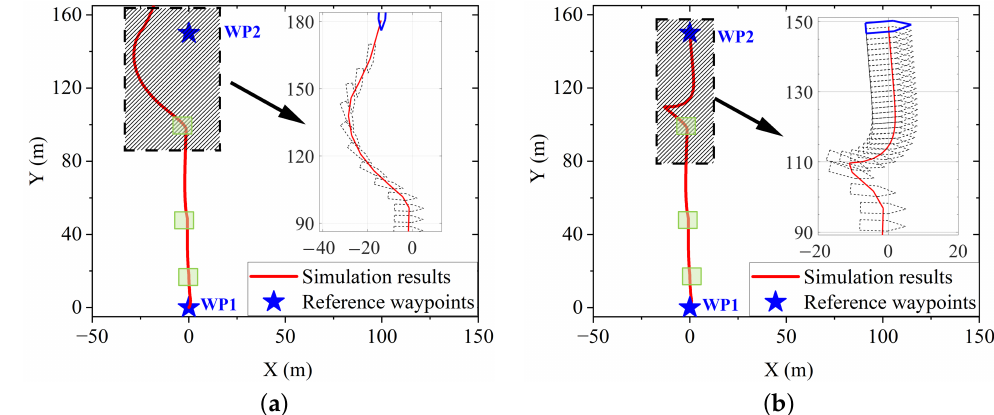
Figure 11. Sideways movement results. ( a ) Without sway velocity reconfiguration; ( b ) With sway velocity reconfiguration.